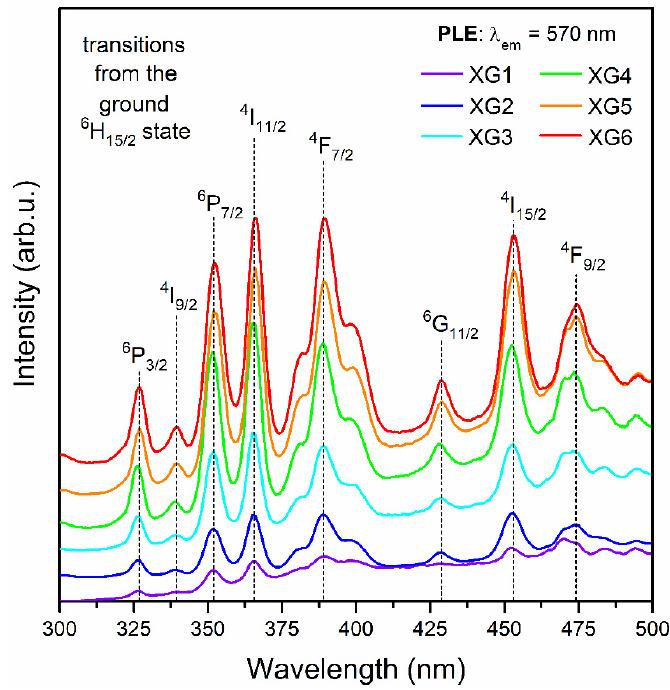
Figure 3. Photoluminescence excitation spectra (PLE) recorded for the series of fabricated xerogels by monitoring the yellow emission at λ em = 570 nm.